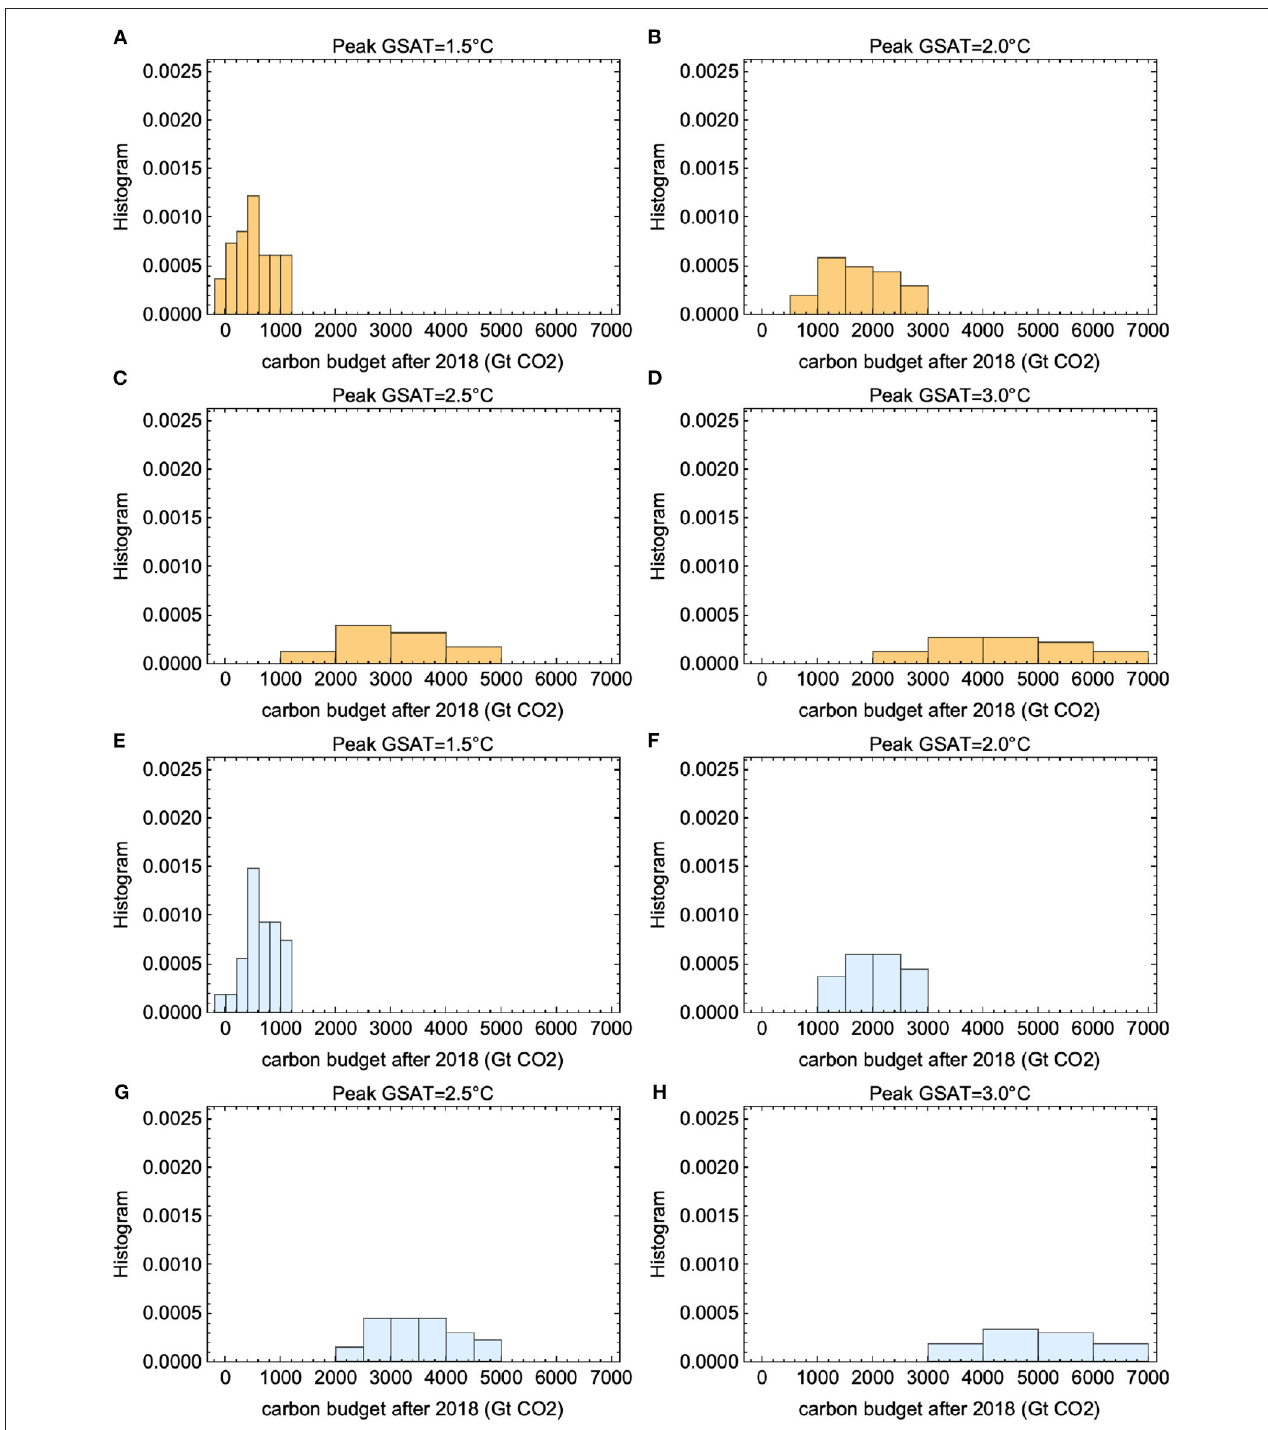
FIGURE 6 | Estimates of RCB for different temperature targets. Panels (A–D) show histograms for the 1.5, 2.0, 2.5, and 3.0 ◦ C-targets, respectively. (E–H) The same estimates, but based only on the temperature response models informed by CMIP6 models with TCR in the range 1.3–2.2 K.